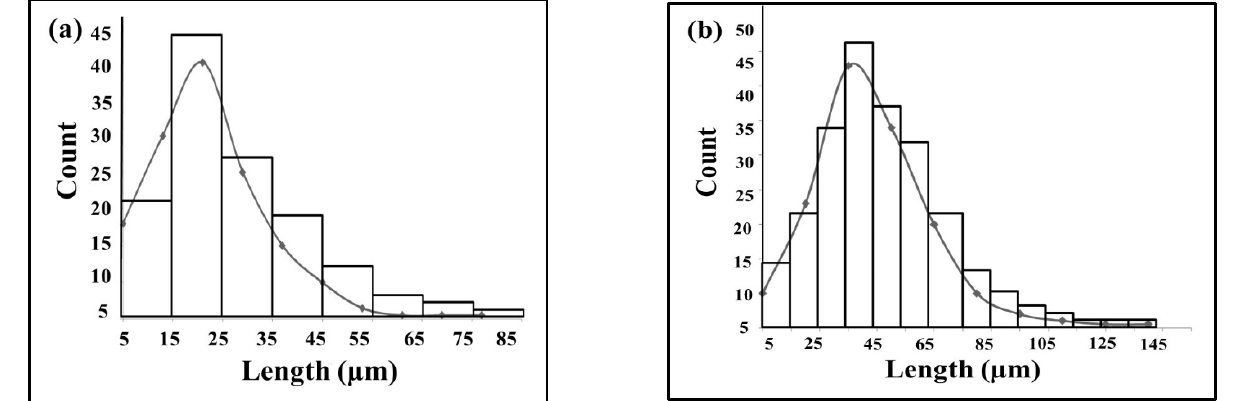
Figure 2. The particle size distribution of ( a ) Si3N4 particles and ( b ) eggshell particles.